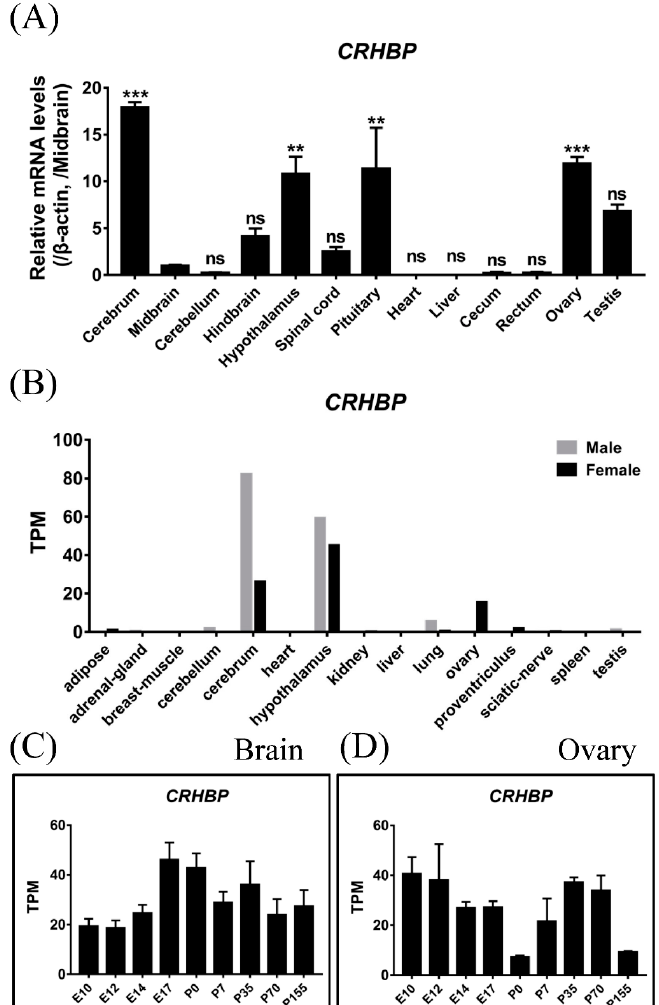
Figure 4. Expression of CRHBP in various chicken tissues. ( A ) Quantitative real-time PCR (qPCR) data showing the expression of CRHBP in adult chicken tissues. The mRNA level of CRHBP was normalized to that of β -actin and expressed as the fold difference compared with that of the midbrain. Each data point represents the mean ± SEM of 6 adult chickens (3 males and 3 females) ( n = 6). **, p < 0.01 vs. midbrain; ***, p < 0.001 vs. midbrain; ns, no statistical difference vs. midbrain. ( B ) RNA- seq dataset from the red jungle fowl (SRP016501) showing the expression of CRHBP in various tissues. ( C , D ) RNA-seq dataset from red junglefowl (E-MTAB-6769) showing the expression of CRHBP in the brain ( C ) and ovary ( D ) during fetal (E10, E12, E14 and E17) and postnatal development stages (P0, P7, P35, P70 and P155). The transcripts per million (TPM) values were used to express the relative abundance of CRHBP